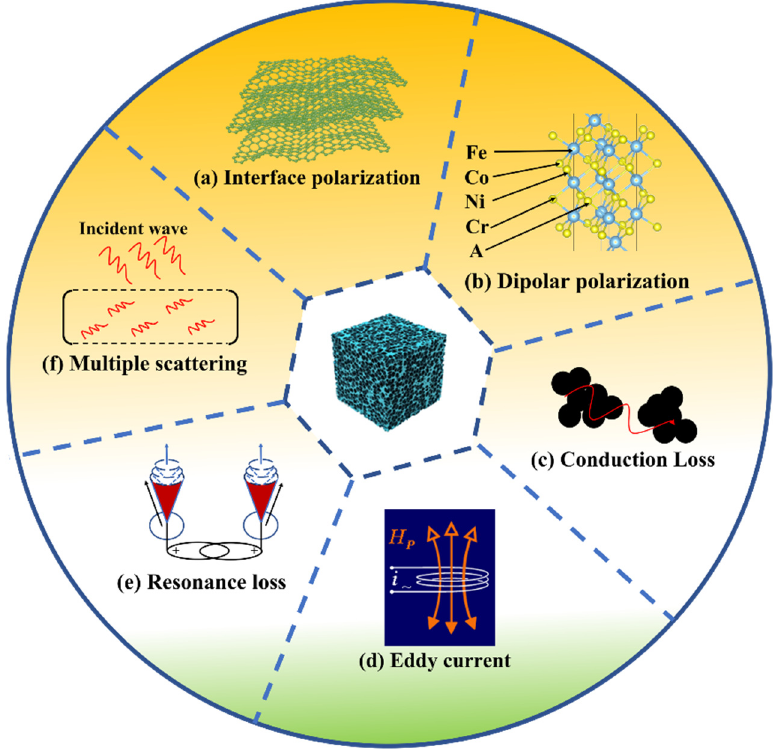
Figure 11. Schematic drawing of EM wave absorption mechanism of the as-prepared HE spinel ferrites.